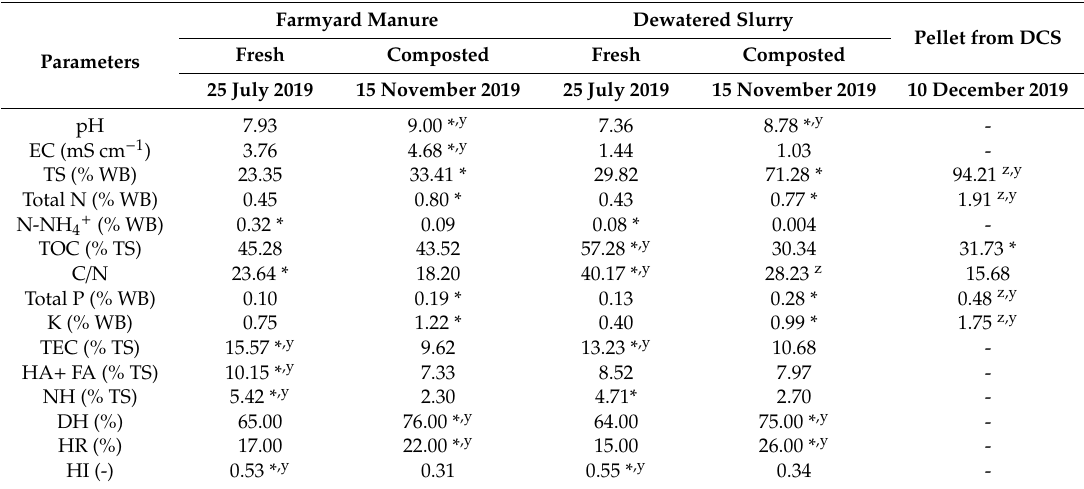
Pellet from DCS